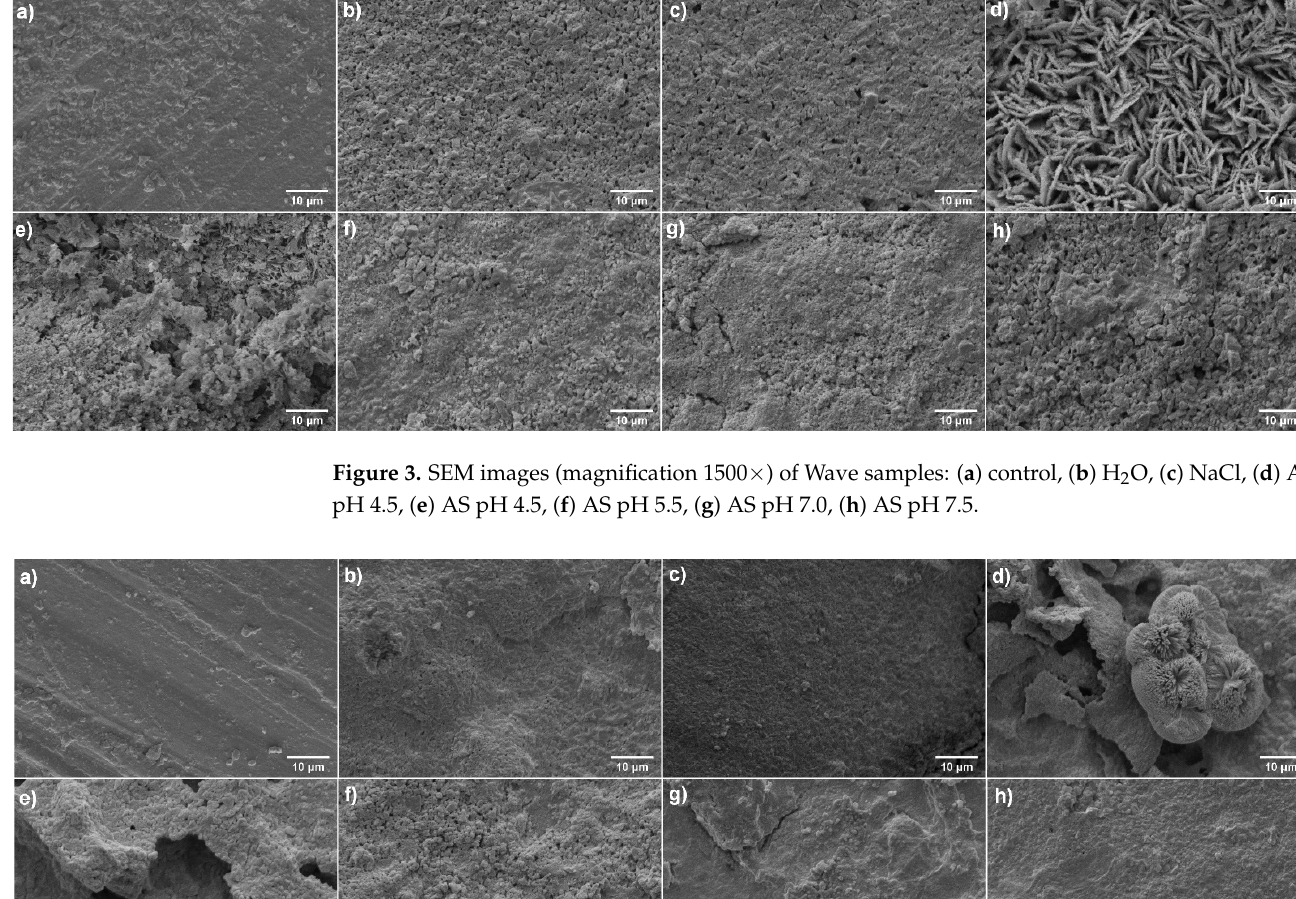
Figure 2. FTIR spectra of Wave ( left ) and Freedom ( right ) materials before and after fluoride release in different media.